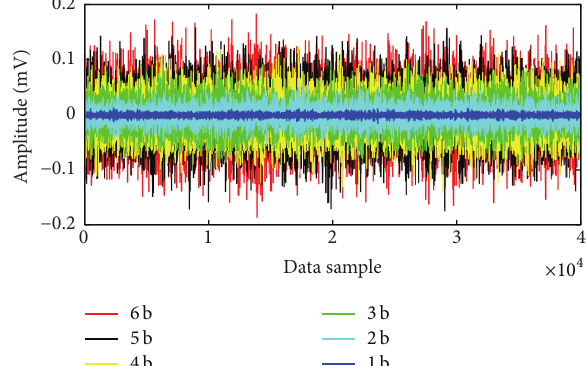
Figure 7: Raw AE signal due to VL through semicracked intake valve in cylinder 2.